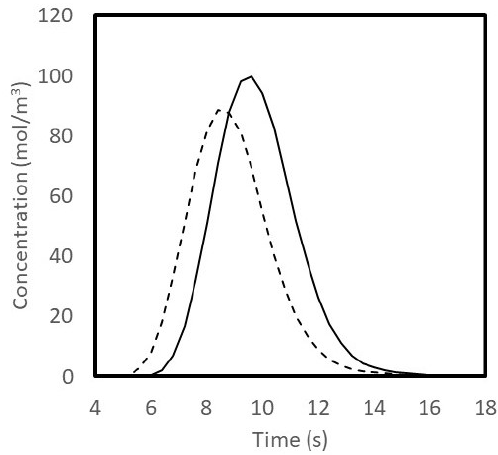
Figure 10. Tracer (sodium chloride) concentration peaks for conventional cylindrical hemodialyzer (dashed line) and cuboid hemodialyzer 2 (solid line).